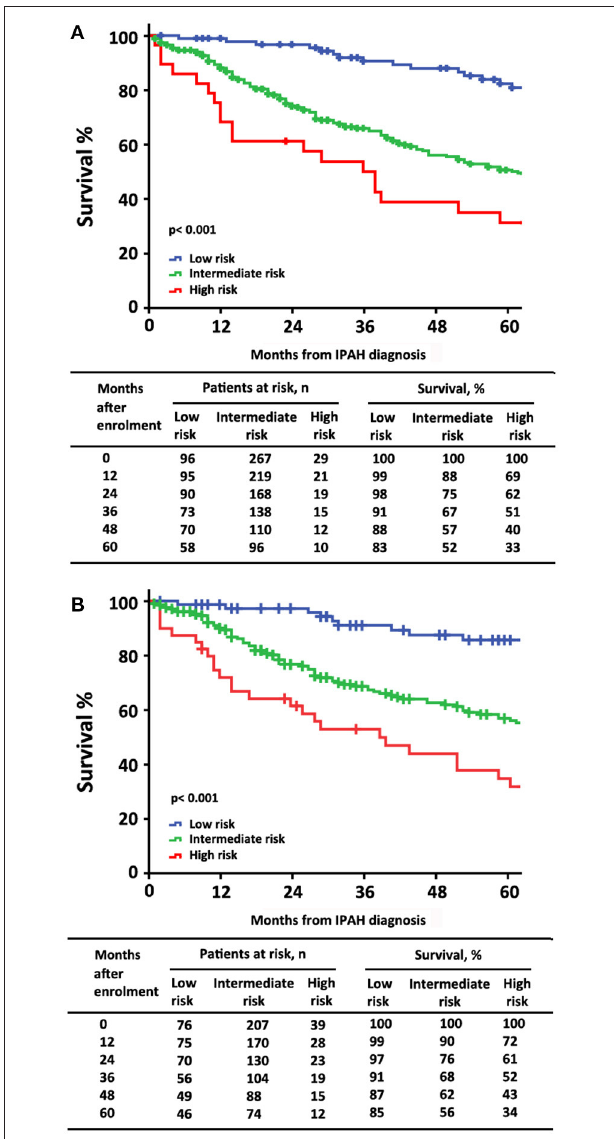
FIGURE 1 | The survival estimates in patients with idiopathic pulmonary arterial hypertension at baseline according to (A) the 2015 European Society of Cardiology/European Respiratory Society (ESC/ERS) risk stratification strategy; (B) a simplified